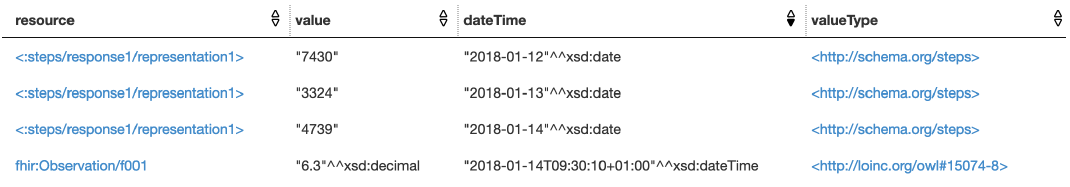
Figure 6. The result of the example SPARQL query for health resources, all the Alice’s health resources that were modeled as lhr:HealtResource are retrieved with their data value, data time, and value